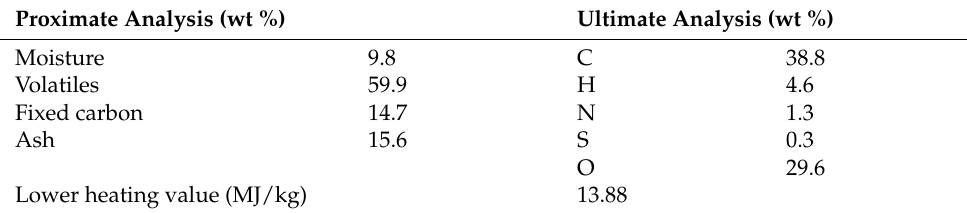
Table 2. Physicochemical properties of rice husk considered for the design of the gasifier (data from [21]). Proximate Analysis (wt %) Ultimate Analysis (wt %) Moisture 9.8 C 38.8 Volatiles 59.9 H 4.6 Fixed carbon 14.7 N 1.3 Ash 15.6 S 0.3 O 29.6 Lower heating value (MJ/kg)